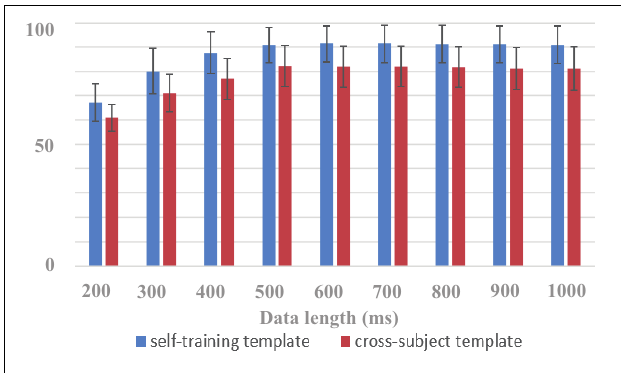
FIGURE 7 | Performance of cross-subject zero-training and self-training methods (block 1 for training and block 2 for testing).